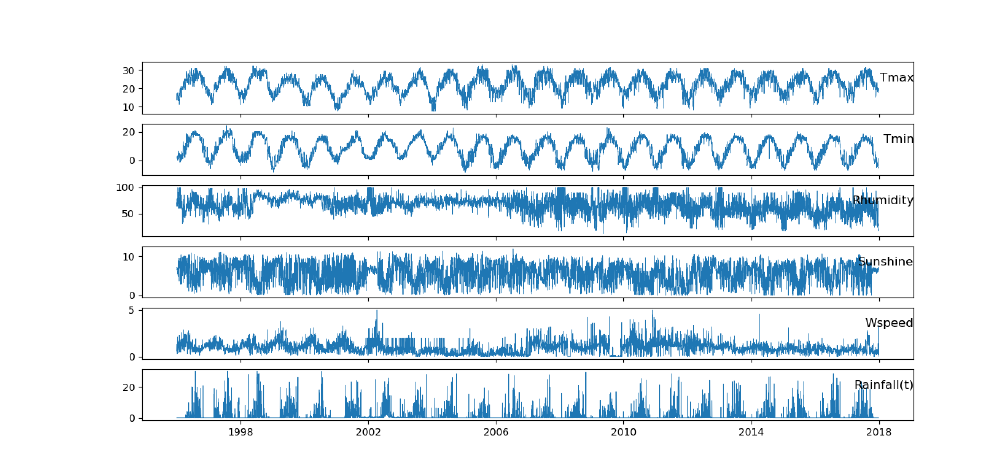
Figure 3. The subplot of weather parameters used in the study from 1998 to 2018.